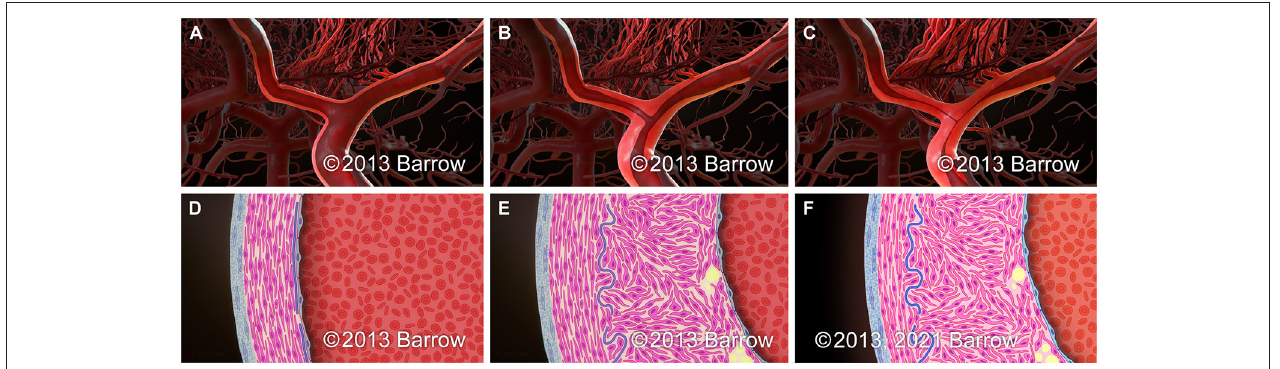
FIGURE 1 | Schematic representation of the paradigmatic progression pattern of arterial stenosis in moyamoya on the macroscopic (A–C) and microscopic (D–F) scale. (A,D) Normal terminal ICA. (B,E) Early in the progression of moyamoya, intimal hyperplasia leads to the development of luminal stenosis without a significant change in the outer diameter of the arterial segment. (C,F) As luminal stenosis continues to progress in moyamoya, attenuation of the medial layer of the artery leads to a reduction in the outer arterial diameter. Used with permission from Barrow Neurological Institute, Phoenix, Arizona .